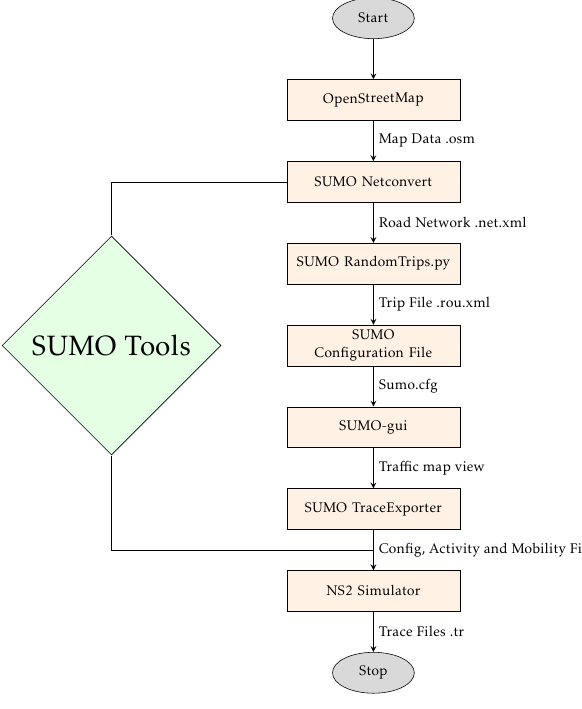
Figure 3. Simulation Process using OpenStreetMap, SUMO, and